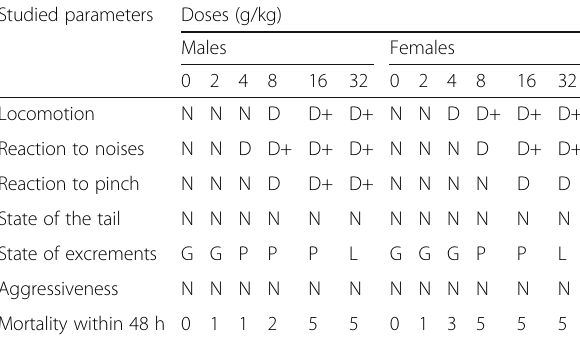
Table 2 Behavioural changes observed during the acute toxicity study of the aqueous extract from A. cordifolia Studied